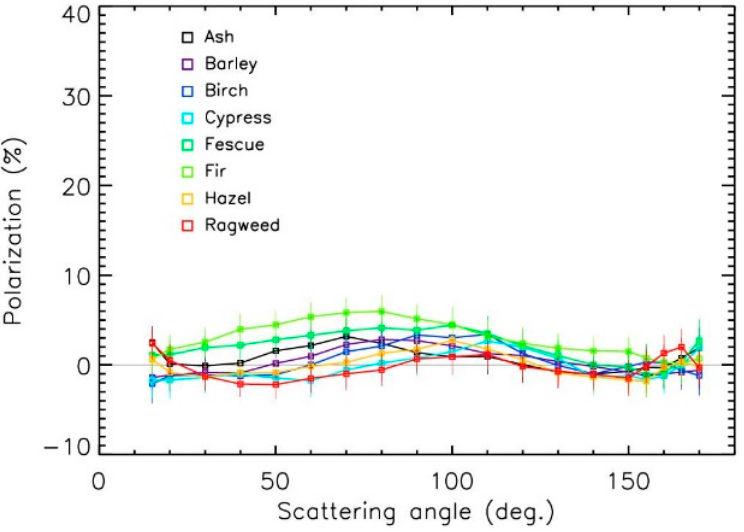
Figure 5. Polarization curves in the red domain for tree pollens.